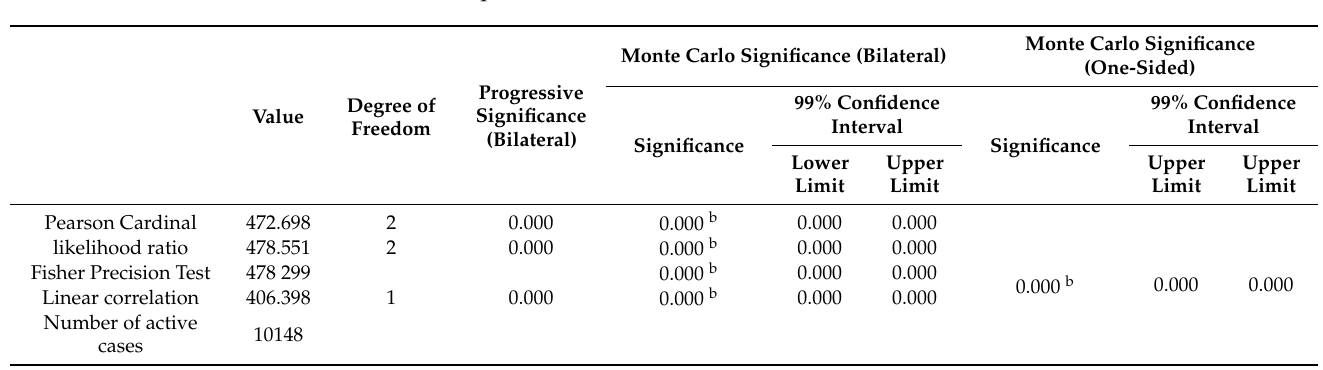
Table 2. Chi-square test.